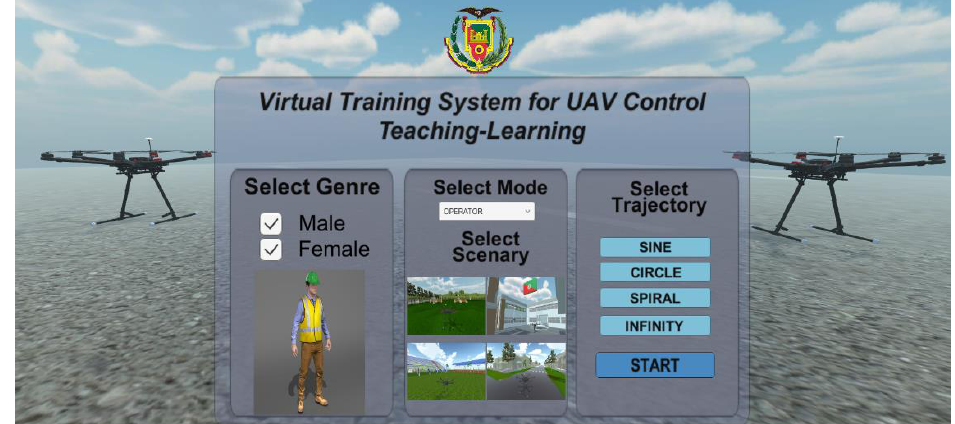
Figure 7. Main window of the virtual interface of the training system.